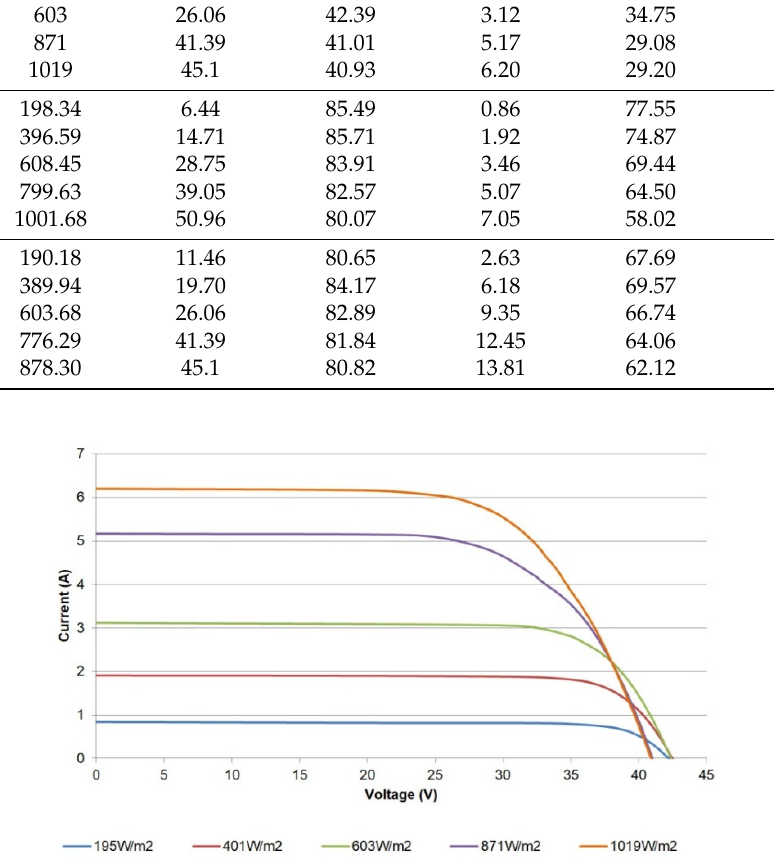
Figure 14. I ‐ V curves for a single PV module. Figure 14. I-V curves for a single PV